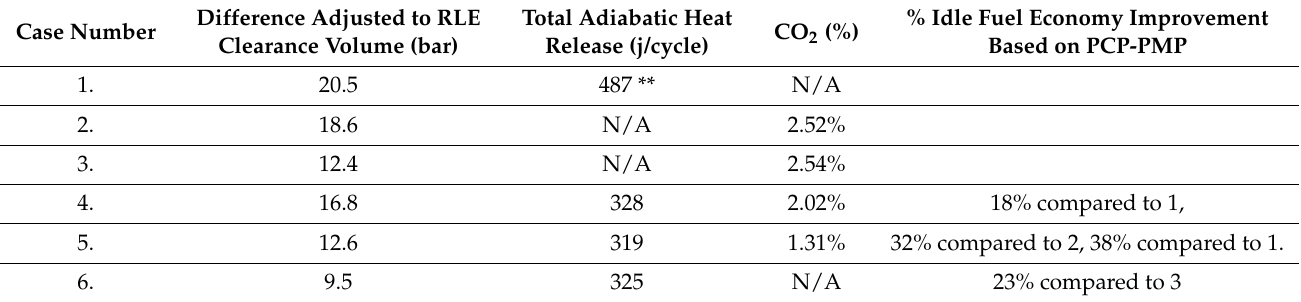
Table 2. Summary of overall results plus total heat release and CO 2 emissions (for details on heat release, see Section